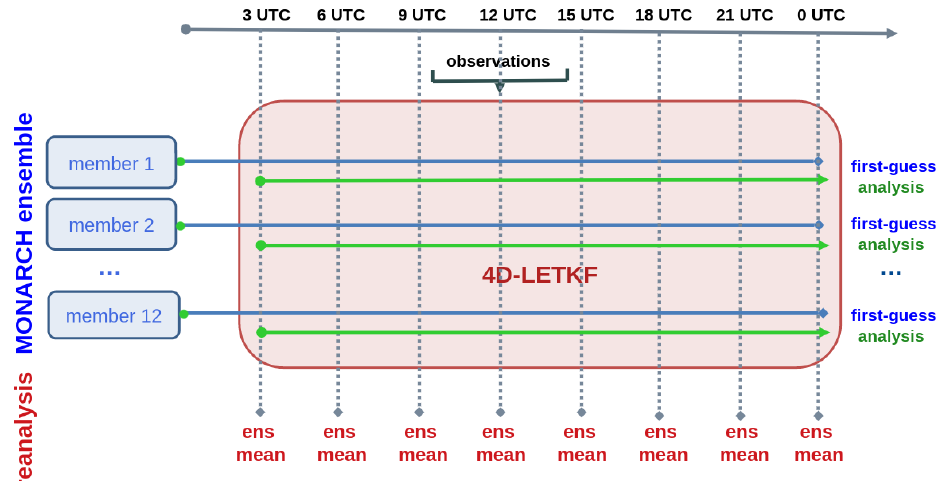
Figure 3. Schematic of the 24h assimilation window for the production of the reanalysis. The ensemble member analyses are used to initialize the corresponding ensemble member first guess in the subsequent simulation/state estimation